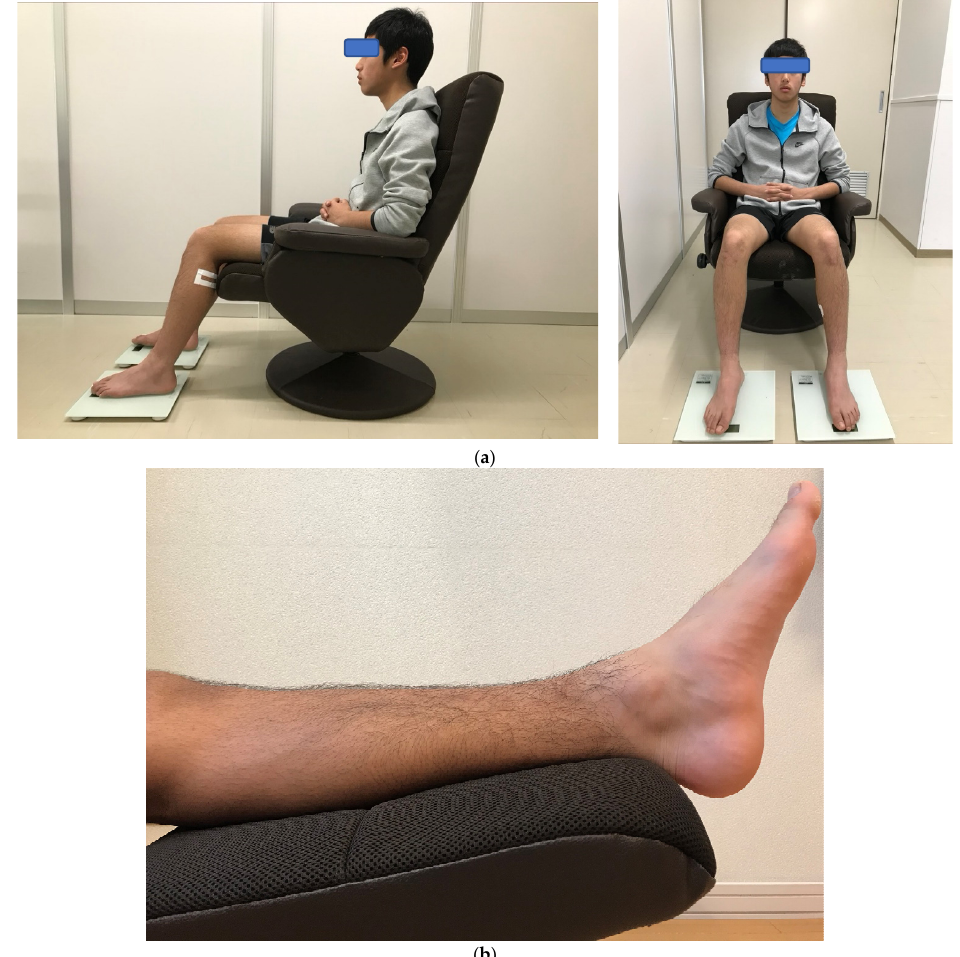
Figure 1. Sitting posture and leg raise appearance. ( a ) Sitting position on a reclining chair. ( b ) Leg raise on a stool. Permission with Plos One 2021 [21].